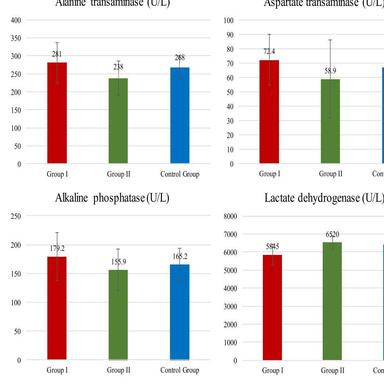
The results of biochemical markers for different groups of laboratory rats after 7 and 14 days of treatment.